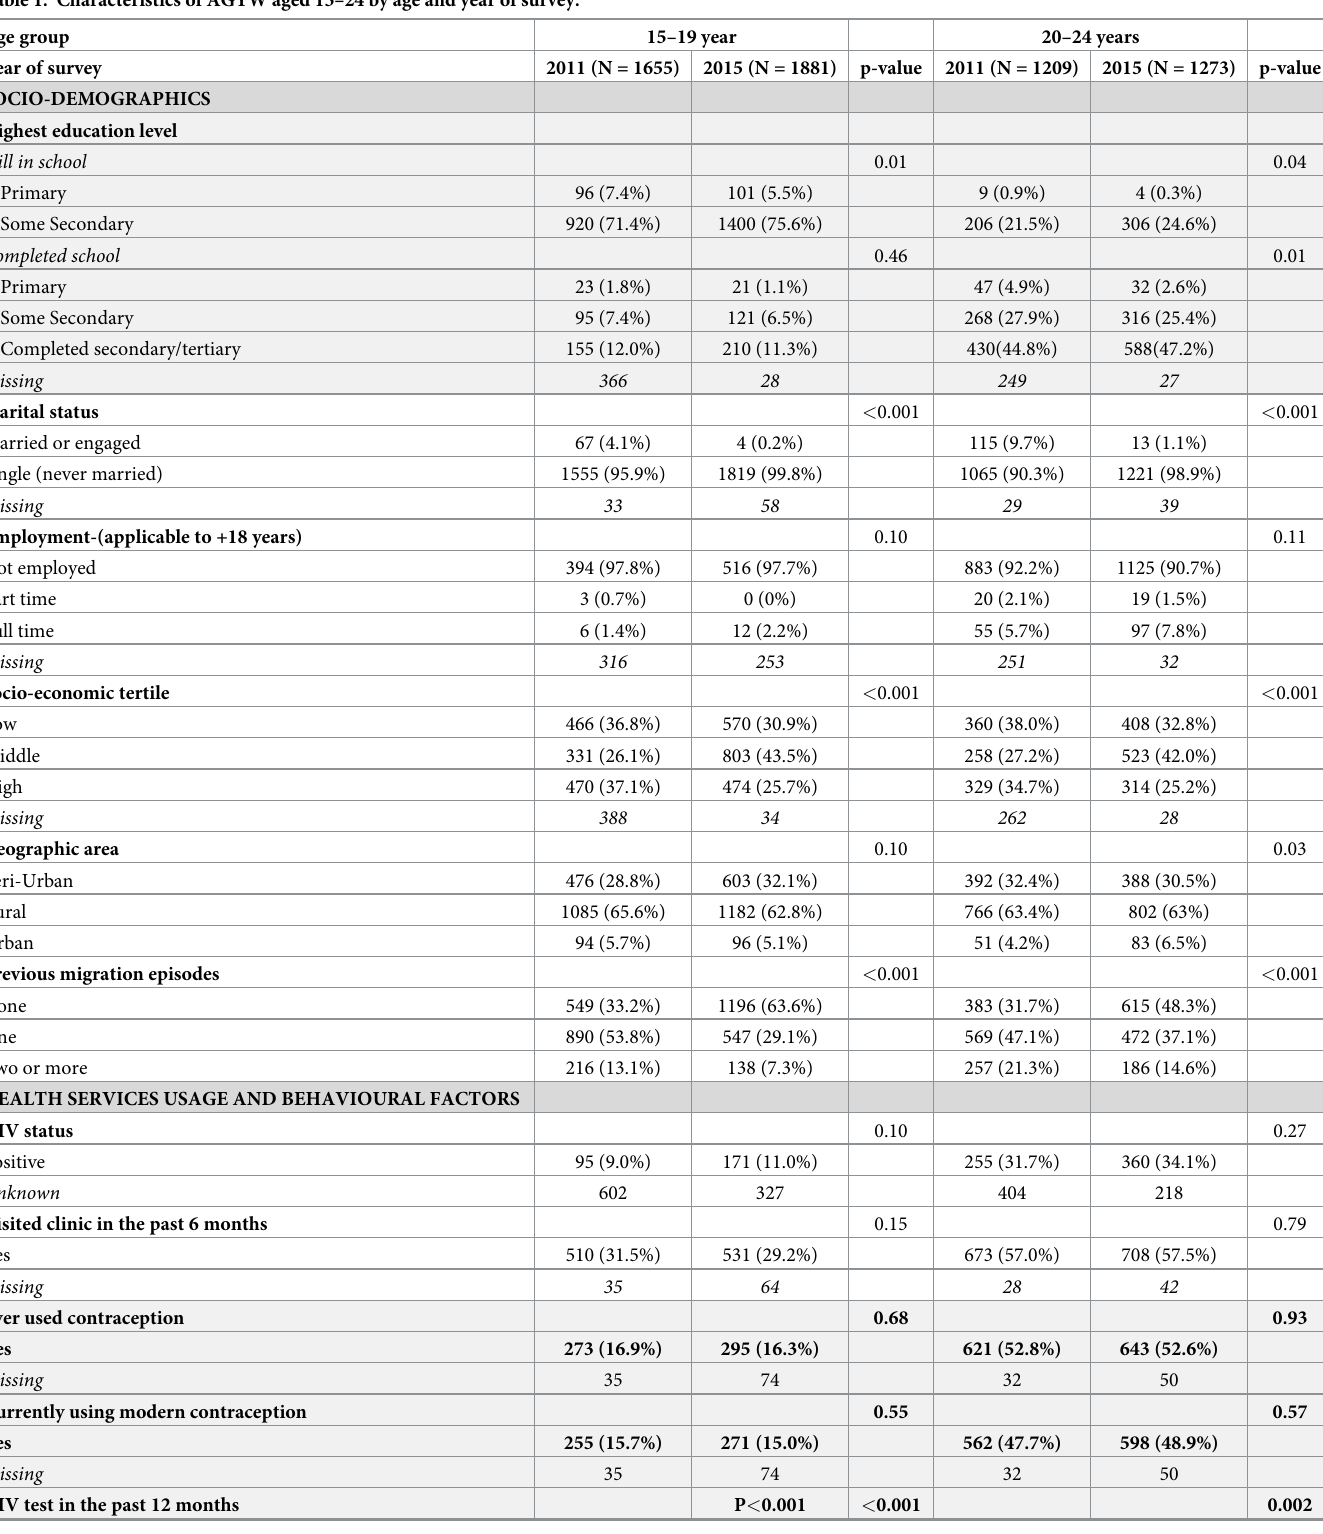
Table 1. Characteristics of AGYW aged 15–24 by age and year of